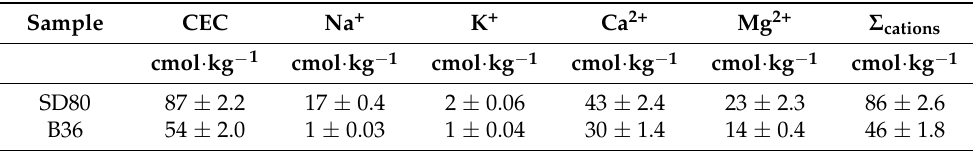
Figure 2. X-ray diffraction pattern of random powders from ( a ) SD80 and ( b ) B36 with Ant: anatase, Cal: calcite, Crs: cristobalite, Fsp: feldspars, Kln: kaolinite, Sme: smectite, Qz: quartz, R wp : weighted residual square sum, R exp : theoretical minimum value for R wp . Table 5. CEC values and exchangeable cations (EC) of both bentonites after Cu-trien saturation (sample weight 150 mg/60